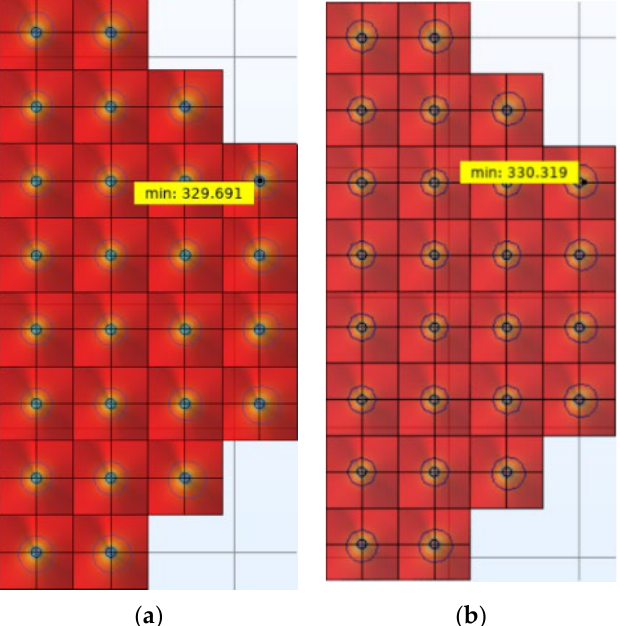
Figure 11. Temperature uniformity results of two generations of calibration targets. ( a ) The first- generation calibration target. ( b ) The second-generation calibration target.